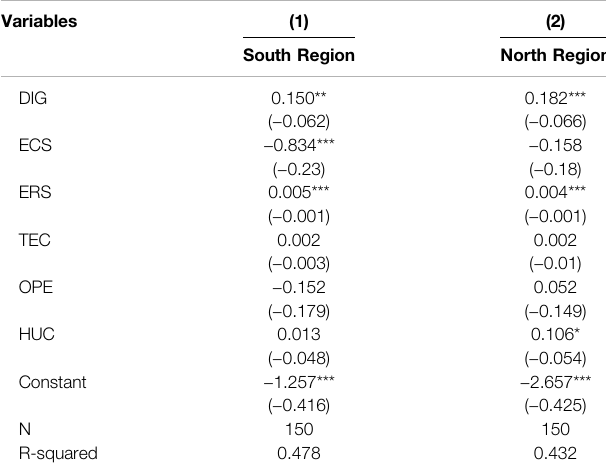
TABLE 7 | Heterogeneity